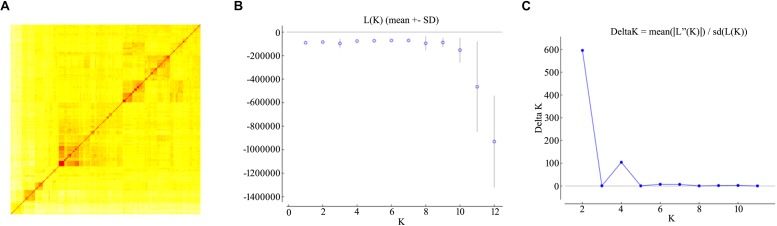
Population stratification of the durum diversity panel. (A) A kinship analysis inferred using a simple matching coefficient. In the heatmap, entries have been clustered using the Wad method. (B,C) STRUCTURE analysis of the durum wheat diversity panel. Log likelihood [L(K)] and ΔK values for each presumed ancestral population number (K) were derived using the admixture model; K was varied from 1 to 12 with five replications for each value of K. L(K) plateaux arose at K = 6 (A), while ΔK showed a distinct and gave an inference of an optimal K at 2 (B).